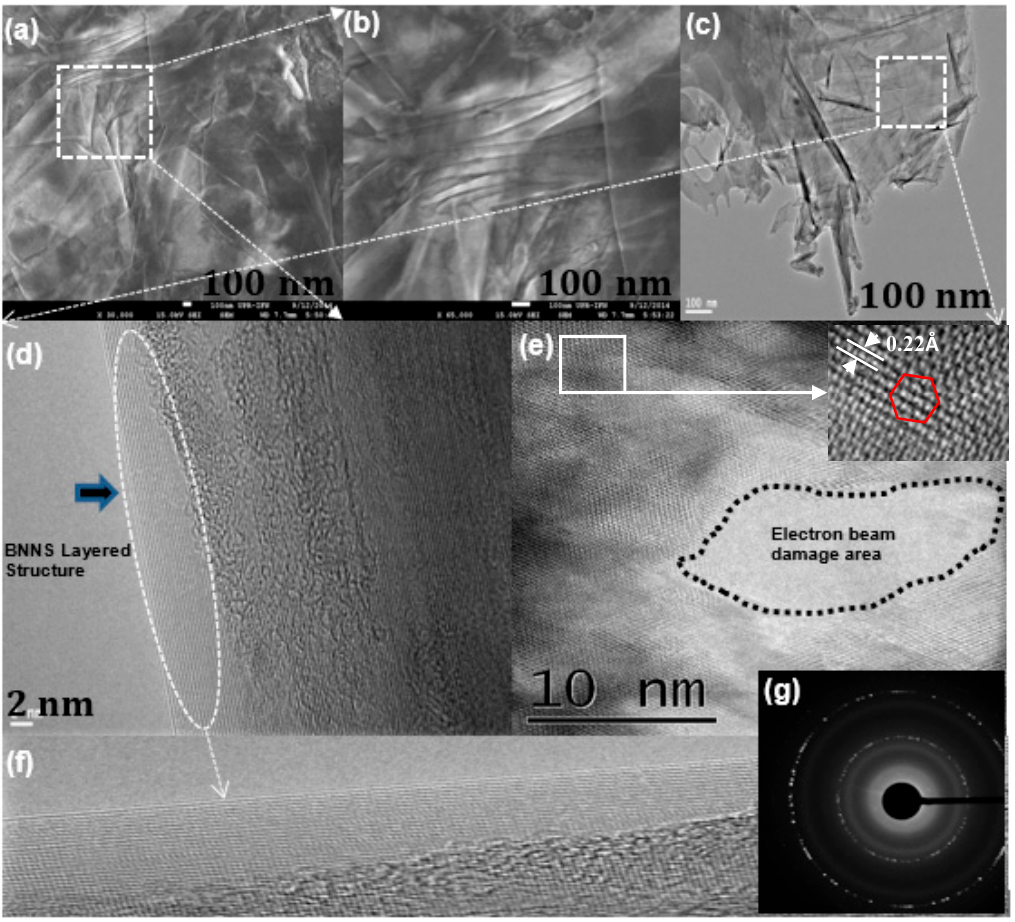
Figure 1. Electron microscopy characterization of boron nitride nanosheets (BNNS). ( a , b ) High-resolution plane view SEM images; ( c ) low magnification TEM image; ( d – f ) high-resolution transmission electron microscope (HRTEM) image and magnified areas of the selected BNNS. Insert in ( e ) confirms that the hexagonal BN structure is identifiable at the atomic scale with lattice constant 0.22Å. ( g ) Selected area electron diffraction pattern indicating polycrystalline nature of BNNS.